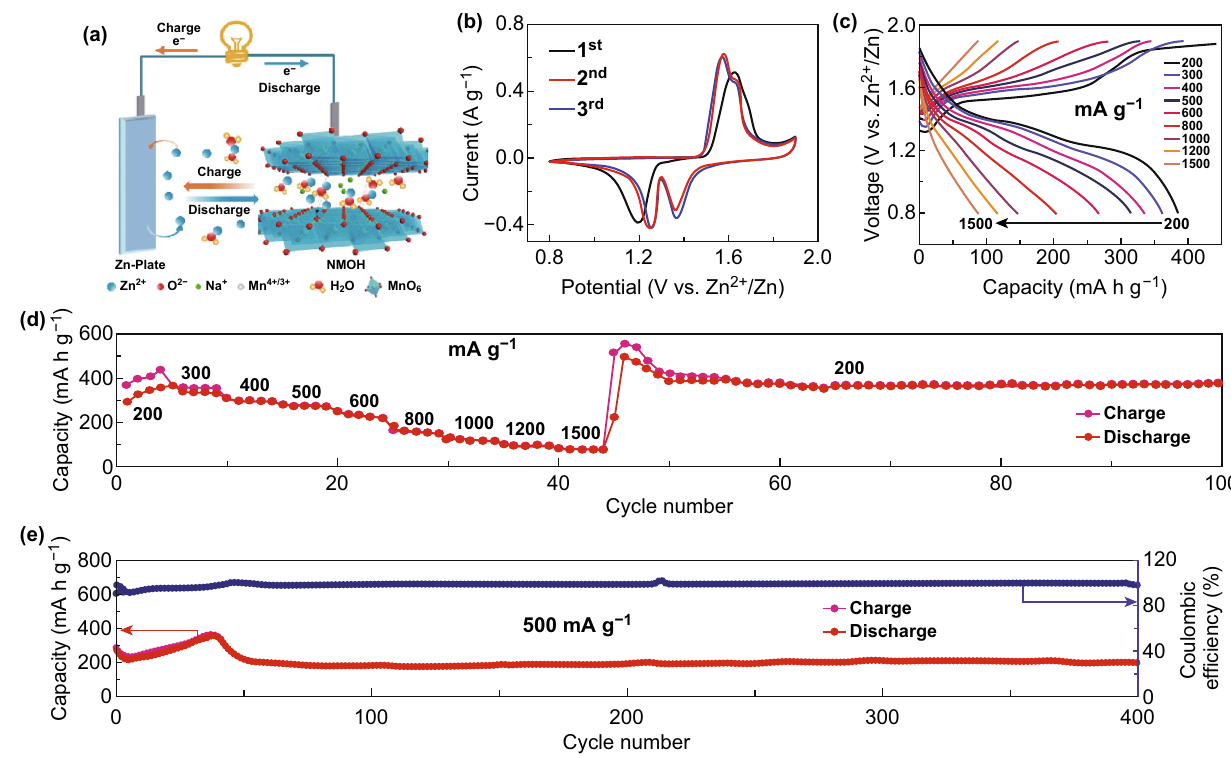
Fig. 3 Electrochemical performances of NMOH electrode. a Working principle of an aqueous ZIB with NMOH as the cathode and Zn foil as the anode. b CV curves of coin‑type Zn/NMOH cell with the aqueous electrolyte of 2 M ZnSO 4 and 0.2 M MnSO 4 at a scan rate of 0.1 mV s −1 . c Galvanostatic charge/discharge profiles of the Zn/NMOH cell tested between 0.8 and 1.9 V with different current densities. d Rate performances of NMOH electrode at current densities between 200 and 1500 mA g −1 . e Long‑cycling performances of NMOH electrode at 500 mA g